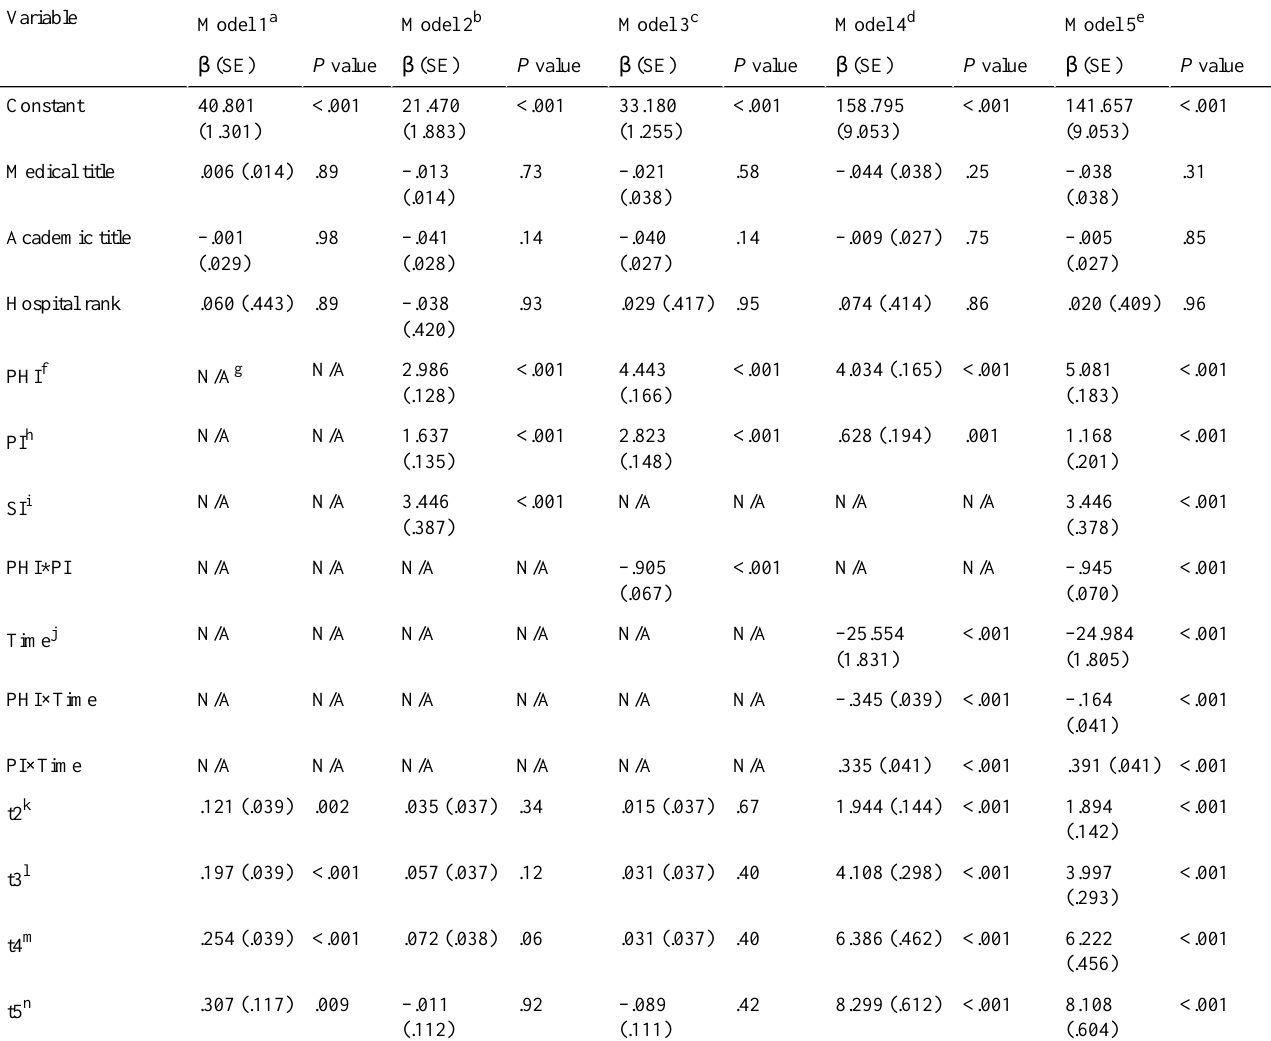
Table 5. Robustness check (fixed-effects